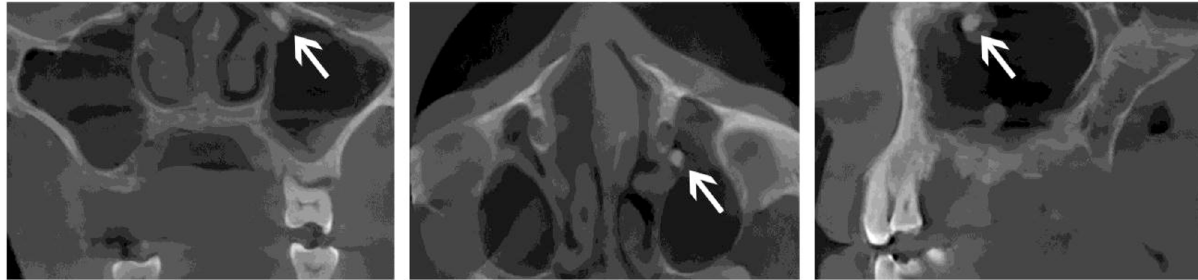
Fig 4. CBCT (cid:2) Frontal/axial/sagittal section: the root is clearly discernible in the left ostium